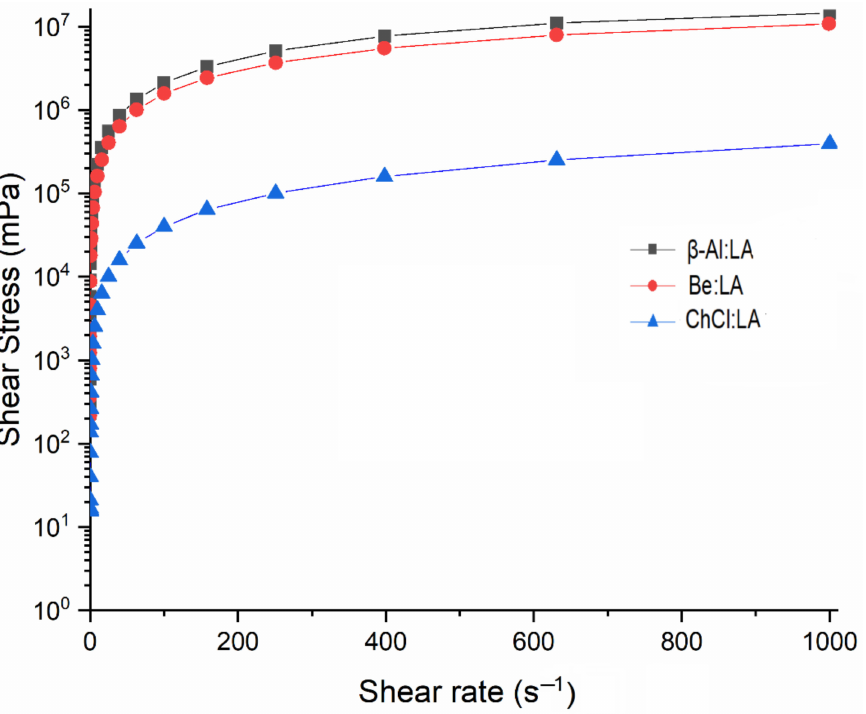
Figure 1. Shear stress variation as a function of applied shear rate for the studied three systems at 25 ◦